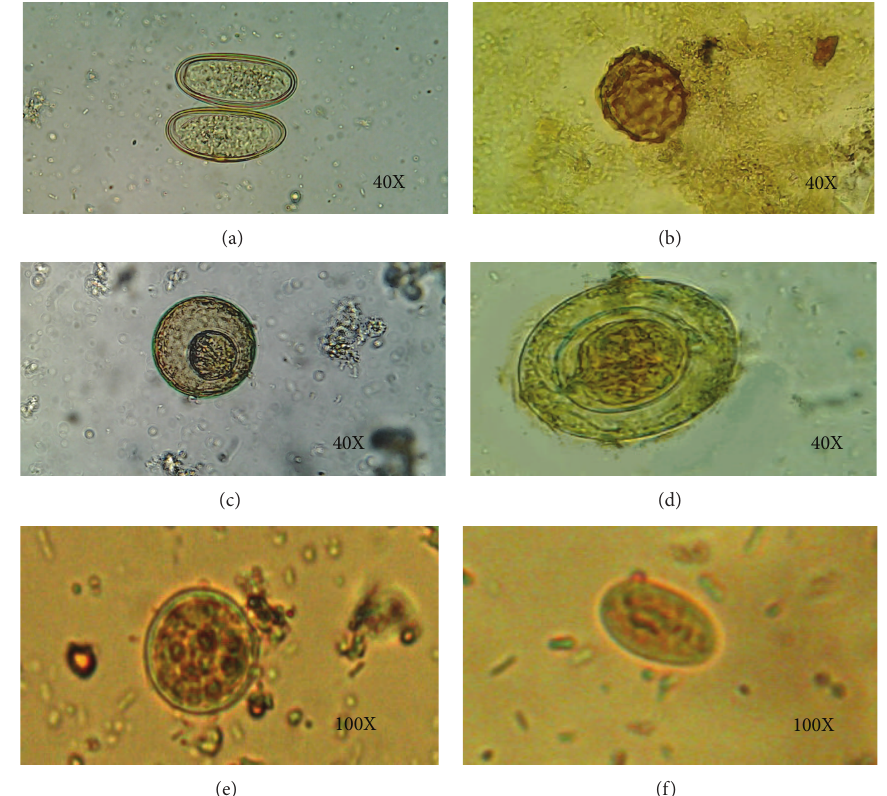
Figure 1: Some of the detected parasitic stages contaminating raw leafy vegetables: (a) Enterobius vermicularis eggs (40X), (b) Ascaris lumbricoides eggs (40X), (c) Hymenolepis diminuta eggs (40X), (d) Hymenolepis nana eggs (40X), (e) Entamoeba coli cyst (100X), and (f) Giardia lamblia cyst